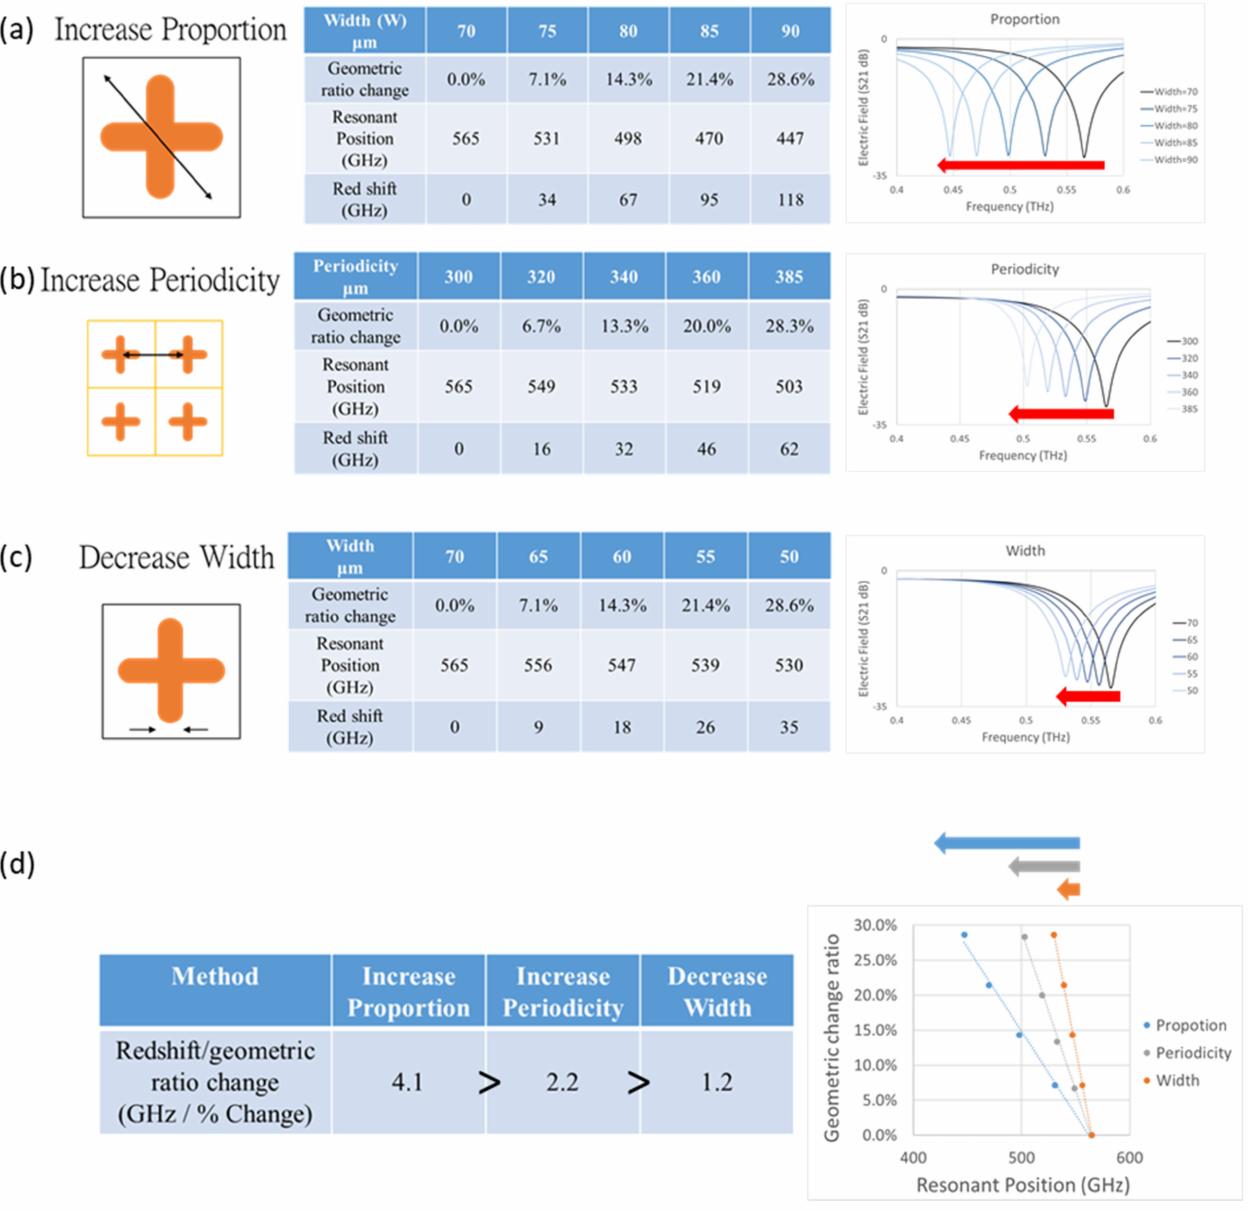
Figure 5. Adjustments to the resonance position by ( a ) increasing proportion, ( b ) increasing periodic- ity, and ( c ) decreasing width. ( d ) Comparison of redshift/geometric ratio